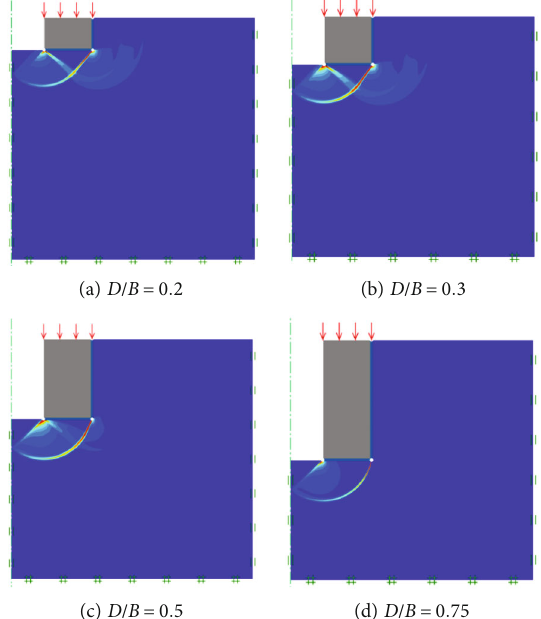
Figure 9: Failure patterns of the ring foundation at di ff erent embedment depths ( η = 0 : 4 ).